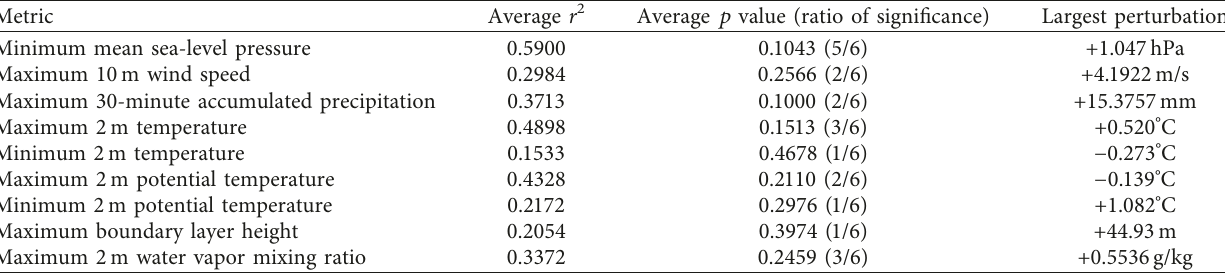
Table 3: Average coefficient of determination ( r 2 ), average p value with the ratio of significant cases (95% confidence), and largest perturbation to cyclone among midlatitude cyclones.